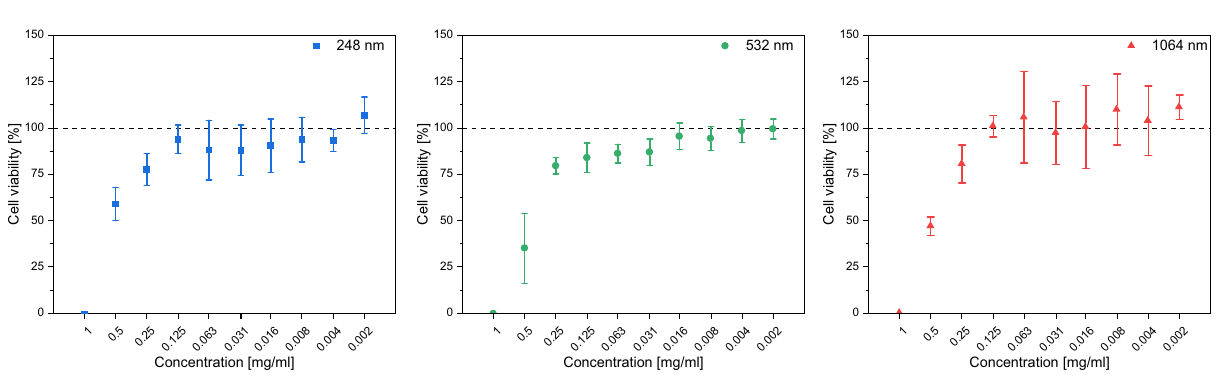
Figure 15. Cell viability in case of the investigated ablation wavelengths (248 nm, 532 nm, 1064 nm).